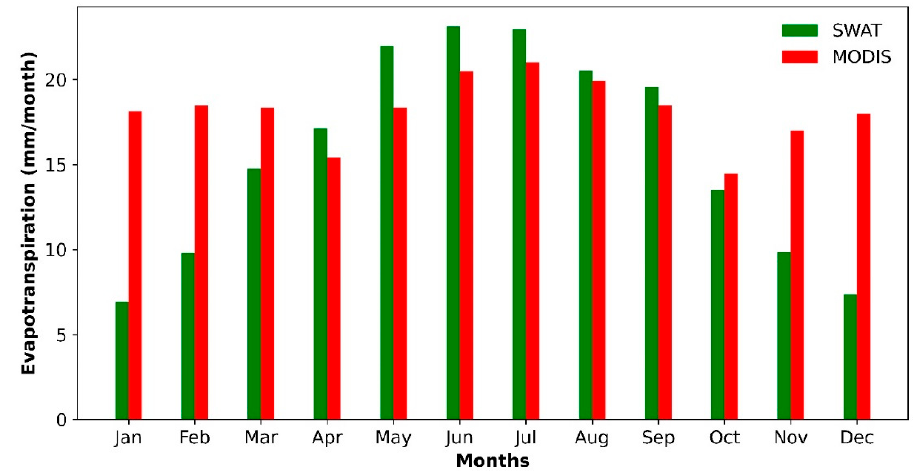
Figure 8. Comparison of long-term monthly SWAT-simulated vs MODIS evapotranspiration data.